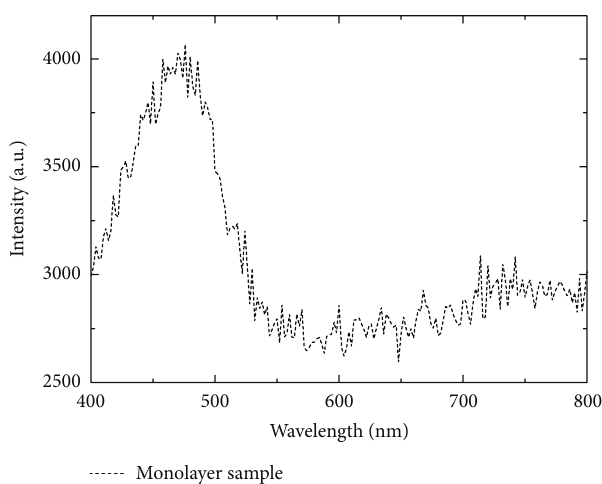
Figure 4: Photoluminescence emission spectra of monolayer sam- ple at 190nm.